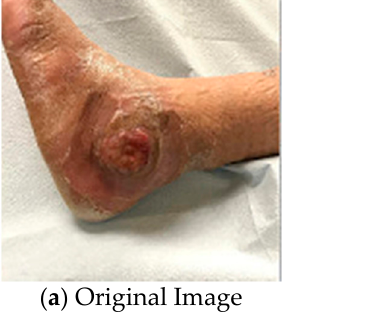
Figure 9. The probabilities of wound types. Diabetic: 29%, pressure injury: 14%, lymphovascular: 56%, surgical: 0% (Diabetic).